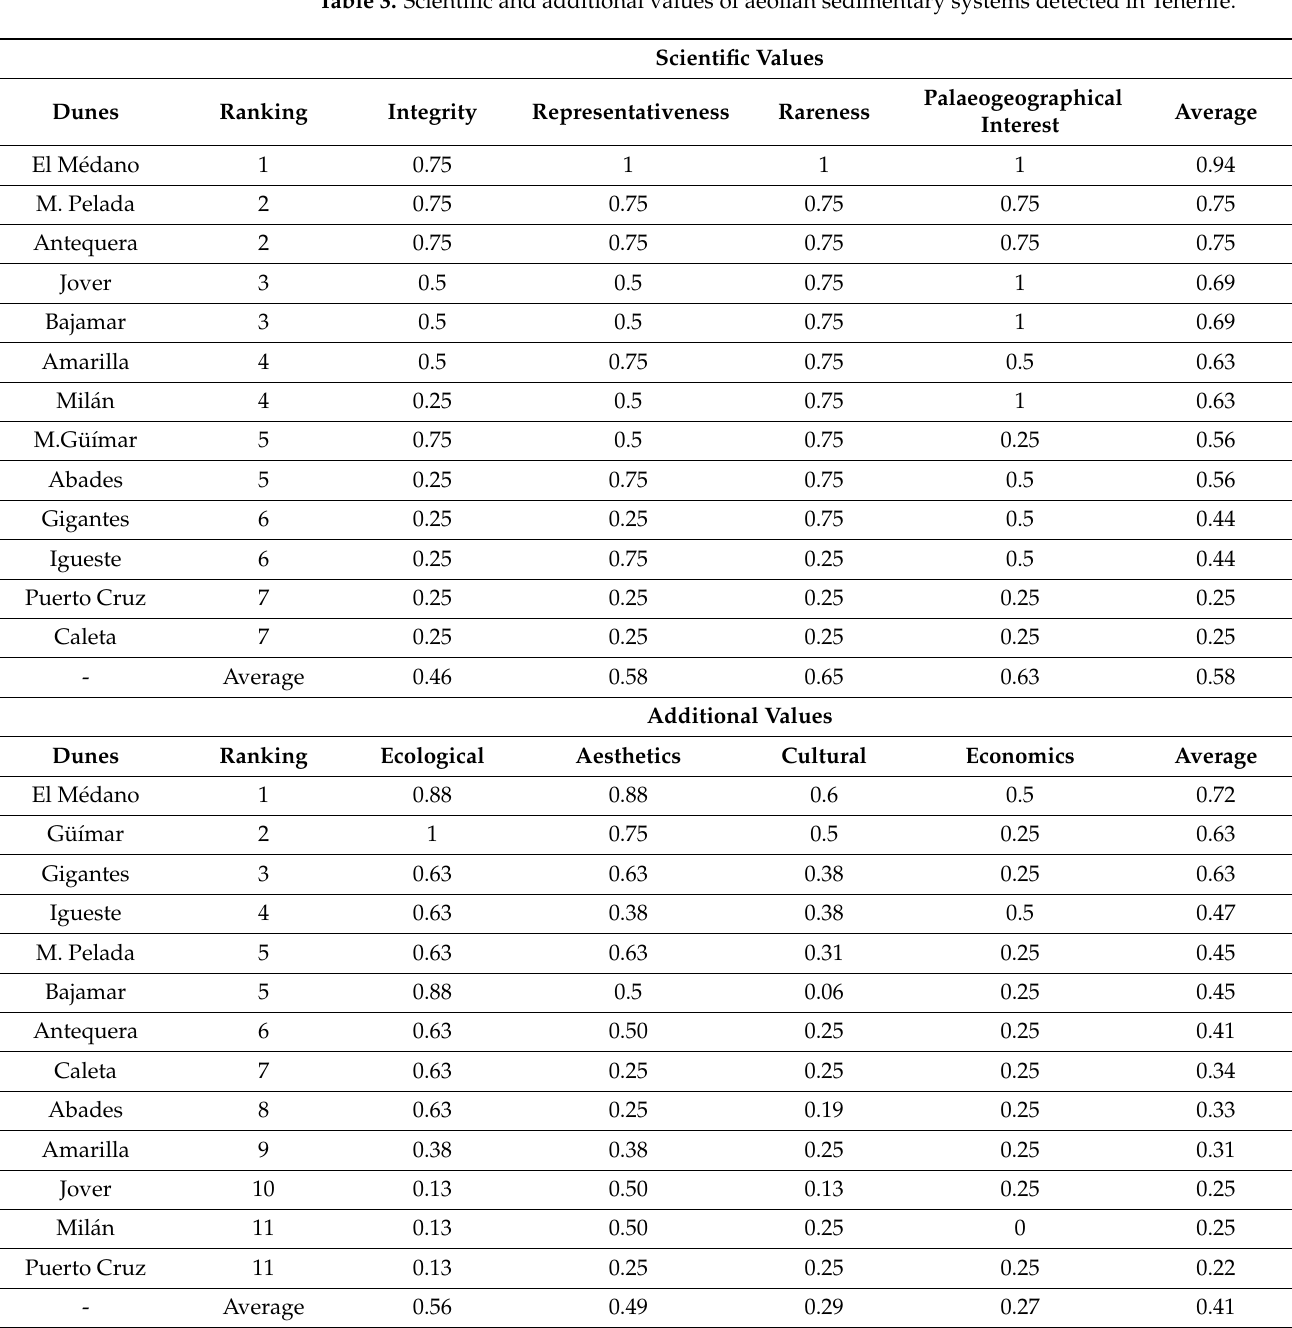
Table 3. Scientific and additional values of aeolian sedimentary systems detected in